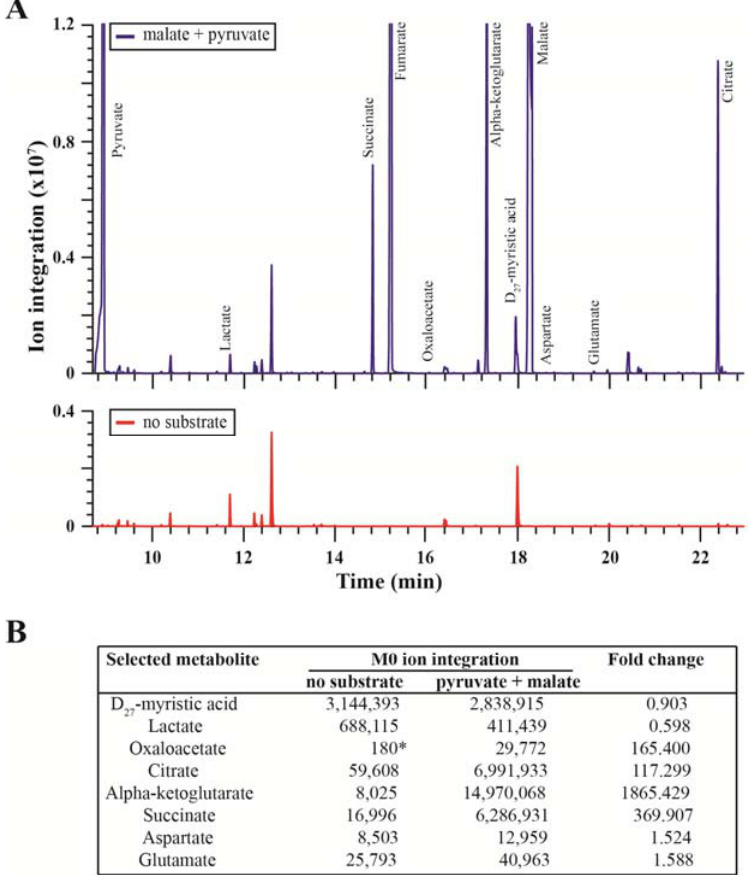
Figure 2. The selected metabolite profile of mitochondria isolated from mouse skeletal muscle obtained by GC/MS (selective ion monitoring (SIM) mode). ( A ) Representative chromatograms obtained from mitochondria incubated in the presence (upper panel, in blue) or absence (lower panel, in red) of respiratory substrates (1 mM pyruvate and 1 mM malate) for 15 minutes. Oxaloacetate, aspartate and glutamate are not abundant enough to be observed on the chromatograms at the depicted scale. The y-axis is set to 1.2 × 10 7 (upper graph) and to 0.4 × 10 7 (lower graph) to allow for better visualization of principal ion peaks. Pyruvate, fumarate, alpha-ketoglutarate and malate peaks are truncated. ( B ) M0 ion integrations for the metabolites studied in this article. The values represent the integrations obtained from the representative chromatograms in Panel A. Fold change values represent the ratio of the M0 ion integration in the presence of pyruvate + malate divided by that in the absence of substrates. Fold change values show that oxaloacetate, citrate, alpha-ketoglutarate and succinate are the metabolites most responsive to the presence of substrates. Pyruvate, fumarate and malate values are saturated and above the upper limit of detection; thus, they are excluded from our analyses. * Oxaloacetate integration in the absence of substrate shows signal-to-noise (S/N) values of Approximately 2.1, while all other integrations display S/N values above